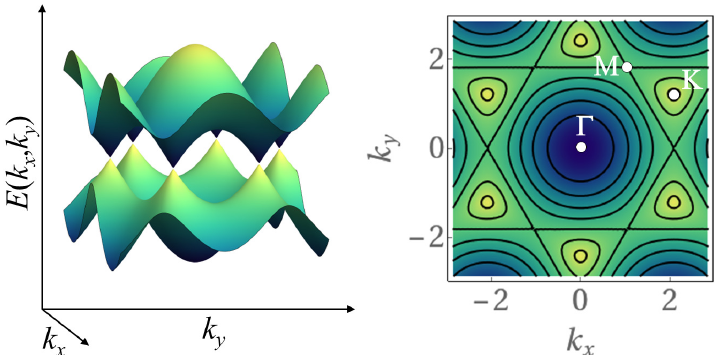
Figure 6. Band structure of a hexagonal lattice: the two-fold energy surface ( left ) and the isofrequency contours ( right ) in the ( k x , k y ) quasimomentum